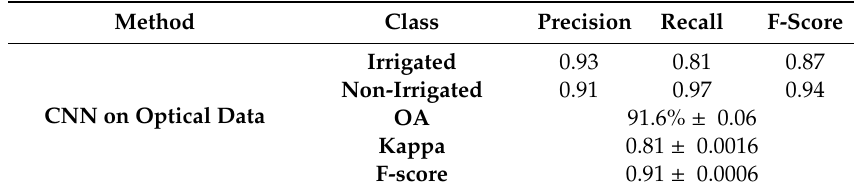
Table 8. The values of the overall accuracy, Kappa, F-score, precision, and recall obtained from the CNN method on NDVI data.